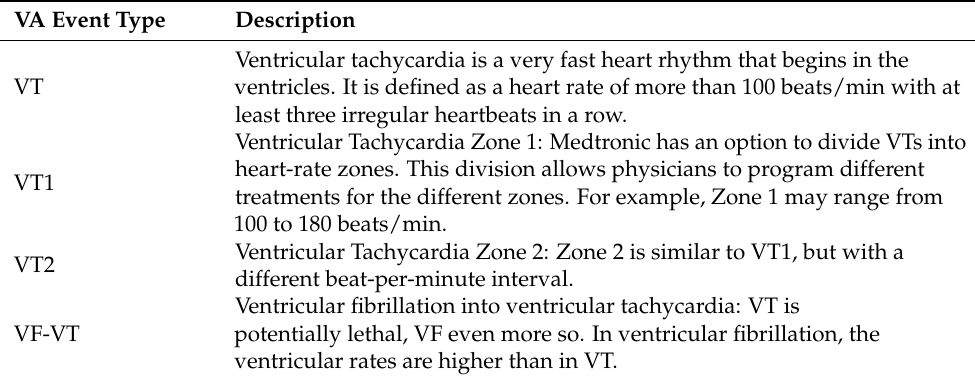
Table 1. VA event types reported by the implanted